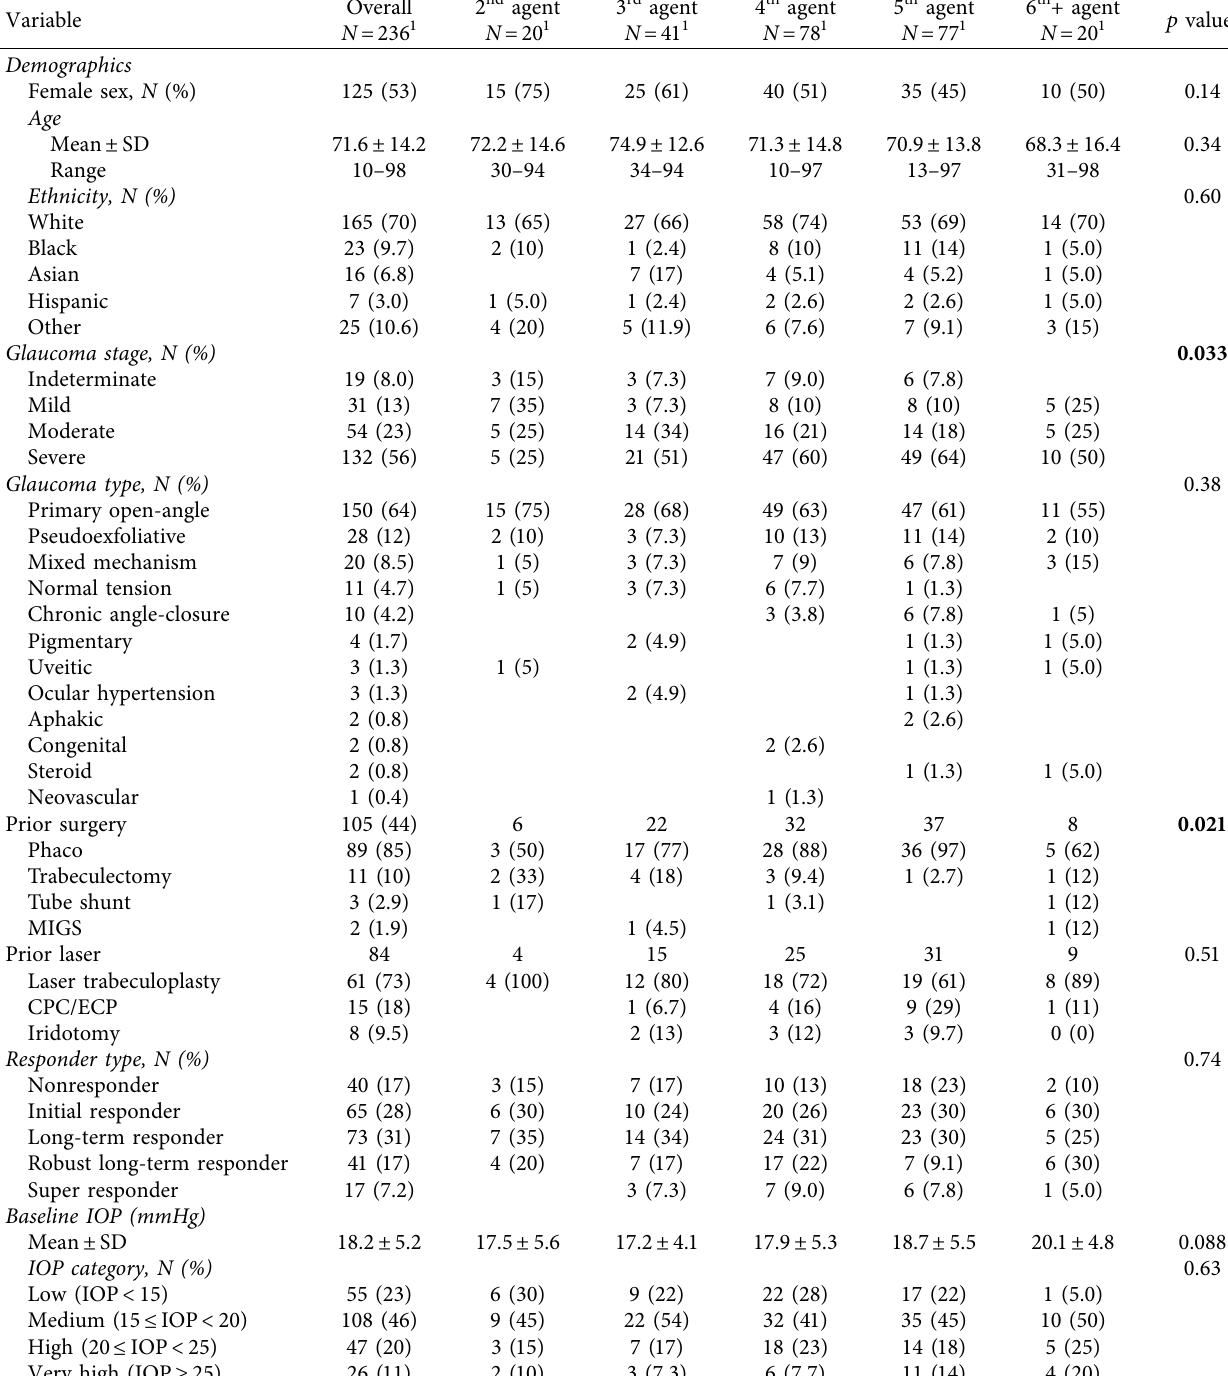
Table 2: Demographic and ocular data characterized by the number of glaucoma